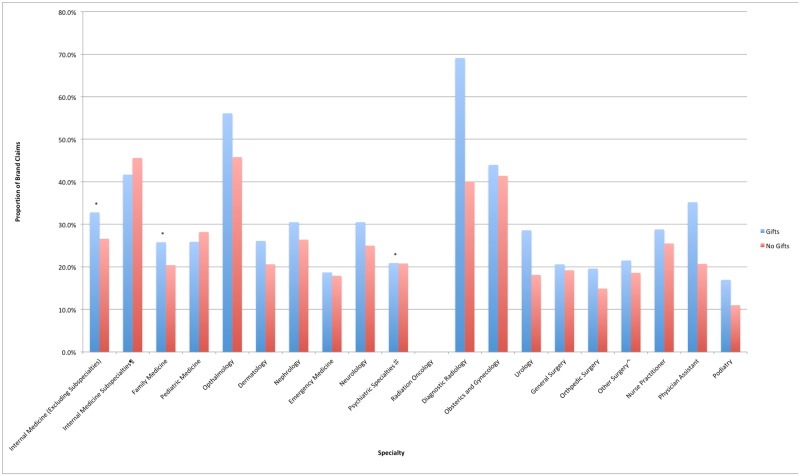
Proportion of branded claims by specialty for gift and non-gift recipients.Proportion of branded claims by specialty by gift and non-gift recipients. ¶ Internal Medicine Specialties includes Cardiology, Endocrinology, Gastroenterology, Infectious Disease, Pulmonary Disease. ♯ Psychiatric Specialties includes Psychiatry, Psychiatry & Neurology, Neuropsychiatry, Geriatric Psychiatry. ⌃ Other Surgery includes Cardiac, Colorectal, Maxillofacial, Oral and Maxillofacial, Plastic and Reconstructive, Plastic, Neurological, Thoracic and Vascular Surgery. *Statistically Significant (p<0.05).